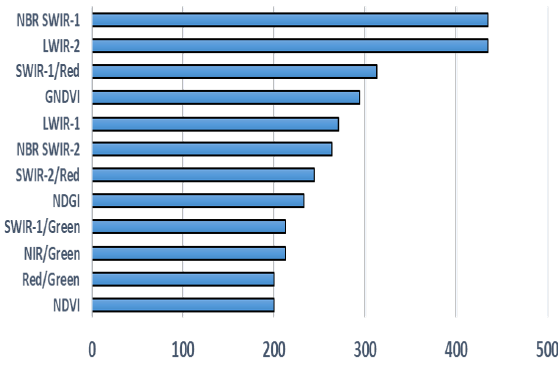
Figure 4. CNN based feature usefulness